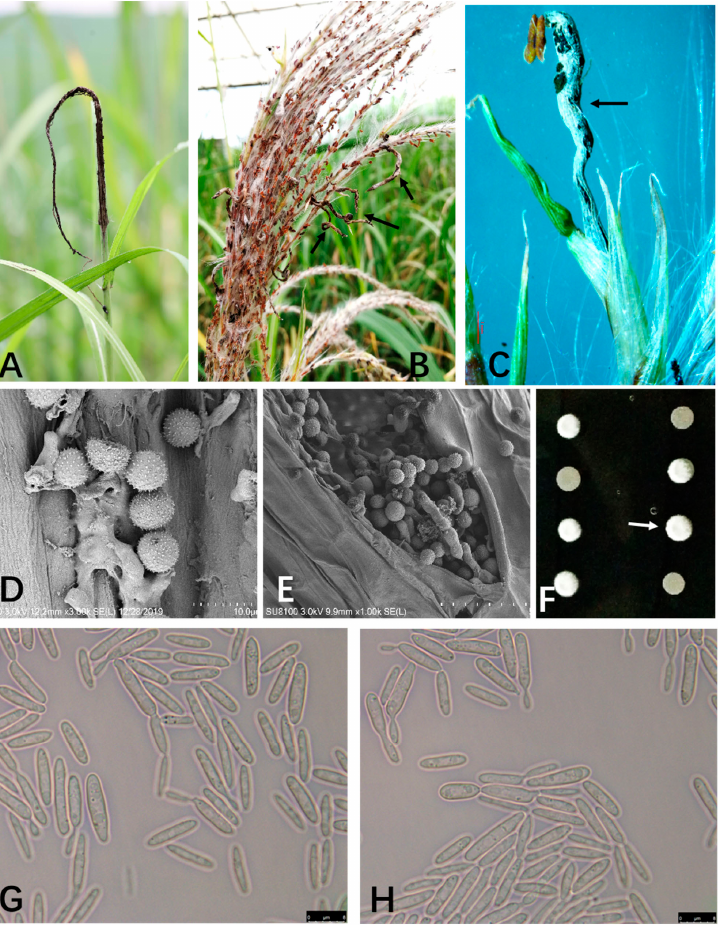
Figure 1. Symptoms of sugarcane smut on flowers and identification of the causal agent. ( A ): Symptom of smut from top of cane; ( B , C ): Symptom of inflorescence smut ( arrows ) in sugarcane; ( D ): Scanning electron microscopy of teliospores isolated from the smut from top of stalk (Ss17 and Ss18 infected); ( E ): Scanning electron microscopy of teliospores isolated from the inflorescence smut; F: Mating assay of haploid strains isolated from smut in flower; different mating type haploid strains mixed randomly on YePSA plates, two strains are regard as different mating types ( MAT-1 and MAT-2 ) if they can cross together (“fluffy” colony, arrows), whereas they are the same mating type (both are MAT-1 or both are MAT-2 ) if they cannot cross (yeast-like colony); ( G ): Microscopic image of haploid sporidia of Ss17; H: Microscopic image of haploid sporidium of Ssf1-7. Scale bar: 10.0 μm in D, 50.0 μm in E, 8.0 μm in G and H.